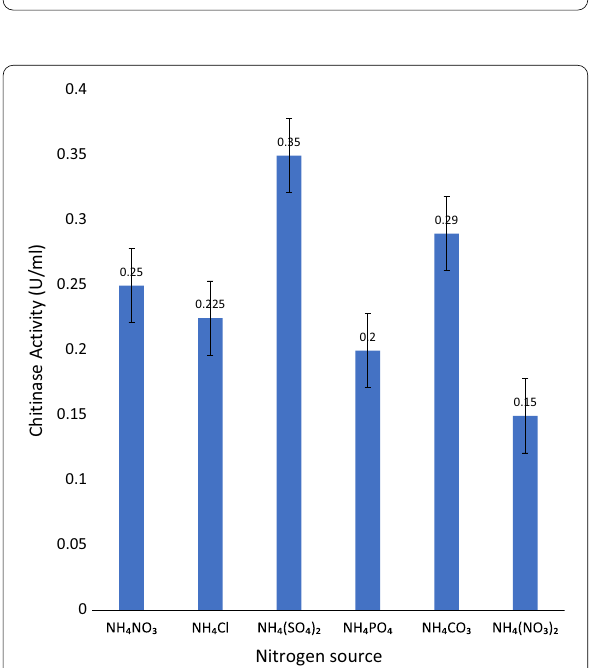
Fig. 4 Chitinase producing activity of Streptomyces albus at different carbon sources